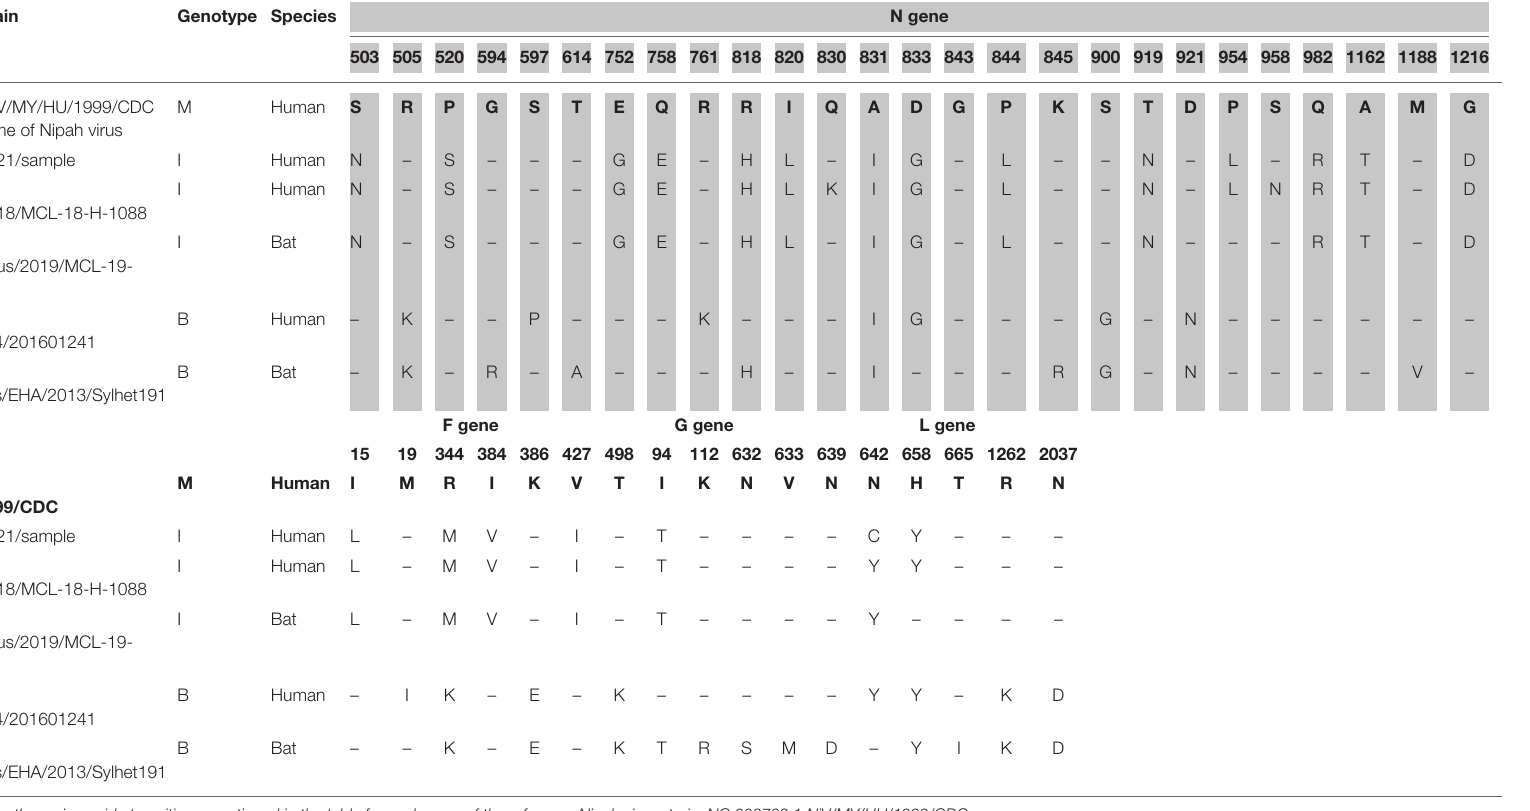
TABLE 1 | Amino acid changes in the different genotypes across representative human and bat sequences for genes encoded by NiV relative to NC 002728.1. Nipah virus strain Genotype